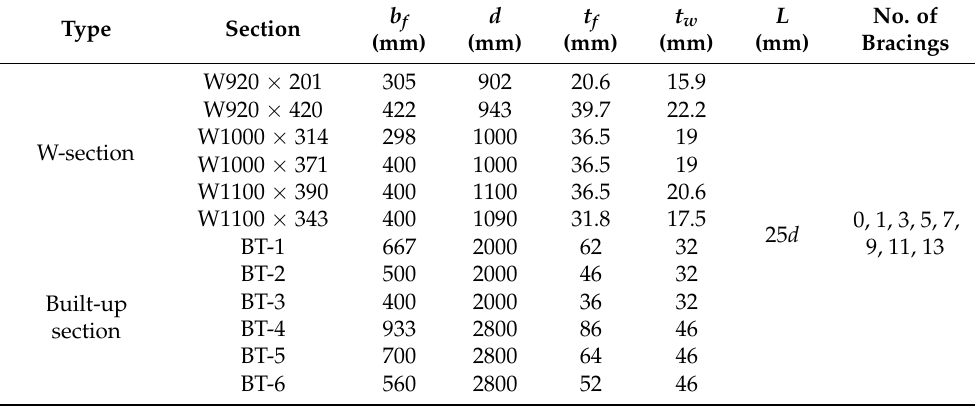
Table 1. Dimensions of I-girder bracing systems in this study (Unit: SI).